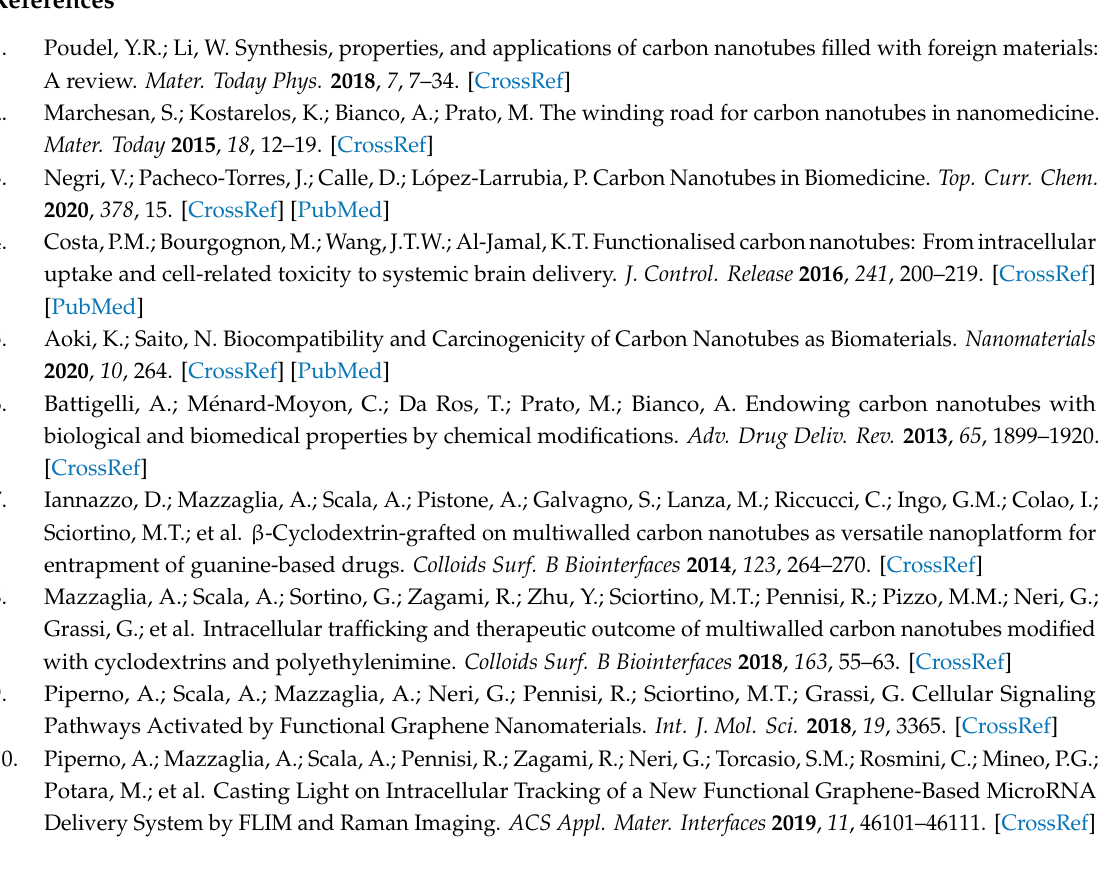
Figure S1: TEM image of pristine MWCNTs; Figure S2: TEM images of MWCNT-EPA / TPPS J-aggregates; Figure S3: STEM of MWCNT-EPA / TPPS J-aggregates; Figure S4: UV-Vis spectra of an aqueous solution of TPPS J-aggregates / MWCNT-EPA (PF protocol) and MWCNT-EPA TPPS J-aggregates (PL protocol); Figure S5: CD spectra of an aqueous solution of TPPS J-aggregates / MWCNT-EPA (PF protocol) and MWCNT-EPA / TPPS J-aggregates (PL protocol); Figure S6: TEM images of TPPS J-aggregates / MWCNT-EPA (PF